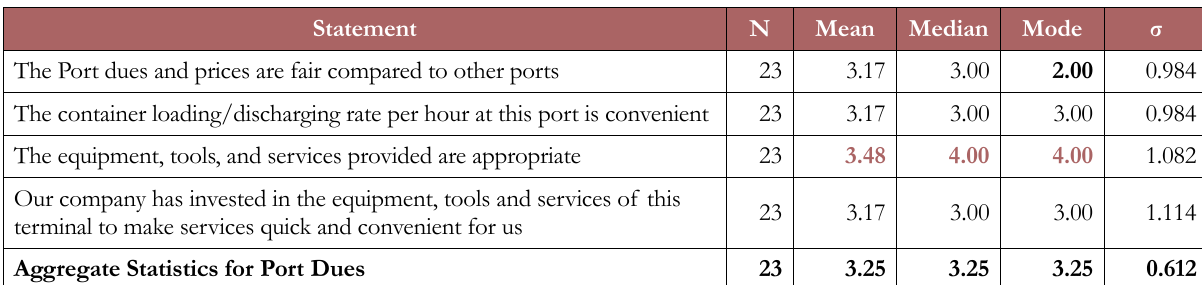
Table 7. Shipping Lines and Agents Perspectives on Sohar Port